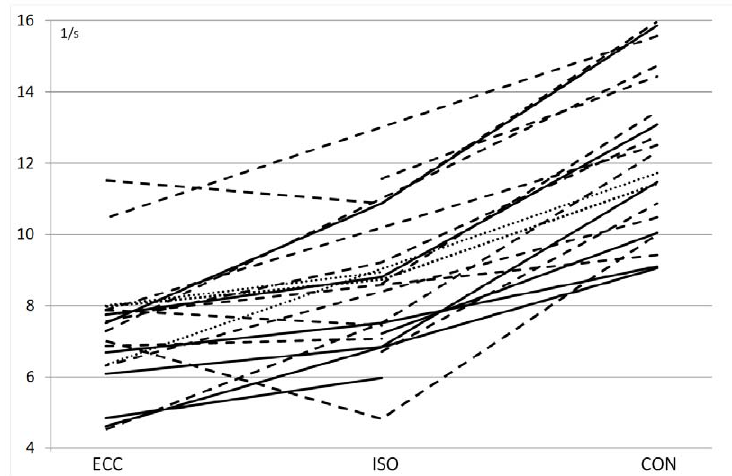
Figure 3. Discharge rates of motor units that could clearly be recognized in at least two of the three contraction types at 10 (solid line), 20 (dashed line) and 40% of MVC (dotted